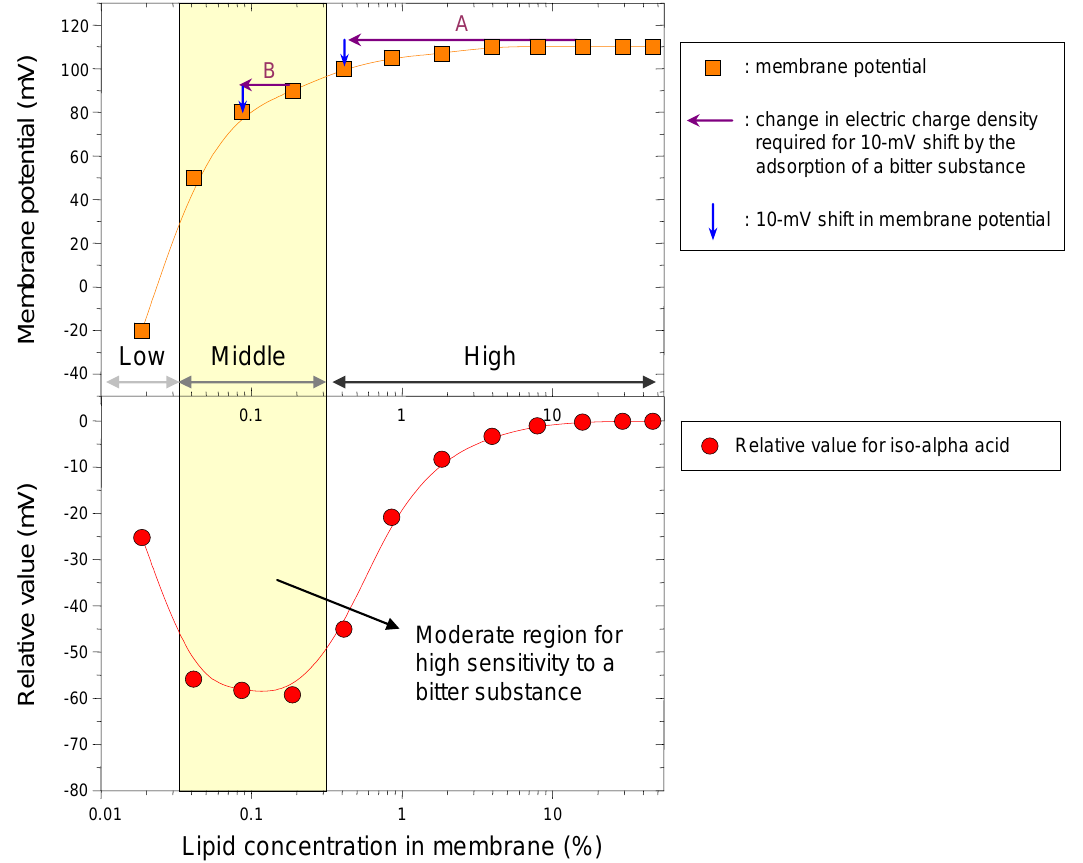
Figure 8. Relationship between lipid concentration in the membrane and membrane potential and the relationship between lipid concentration in the membrane and relative value for iso-alpha acid (Reprinted with permission from the Institute of Electrical Engineers of Japan [53]).